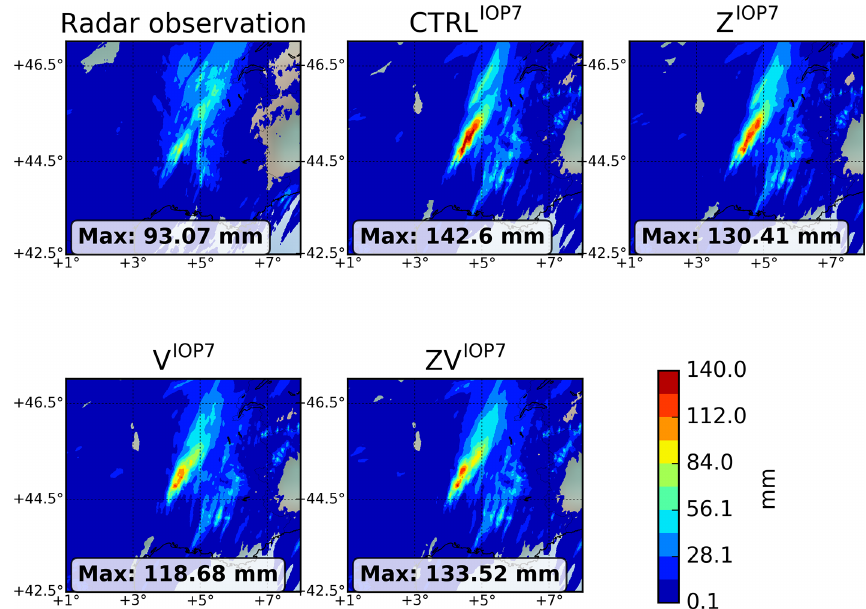
Figure 8. The 12h accumulated rainfall between 06:00 and 18:00UTC 26 September 2012 (IOP7a) for radar observations, the CTRL IOP7 , the Z IOP7 , the V IOP7 and the ZV IOP7